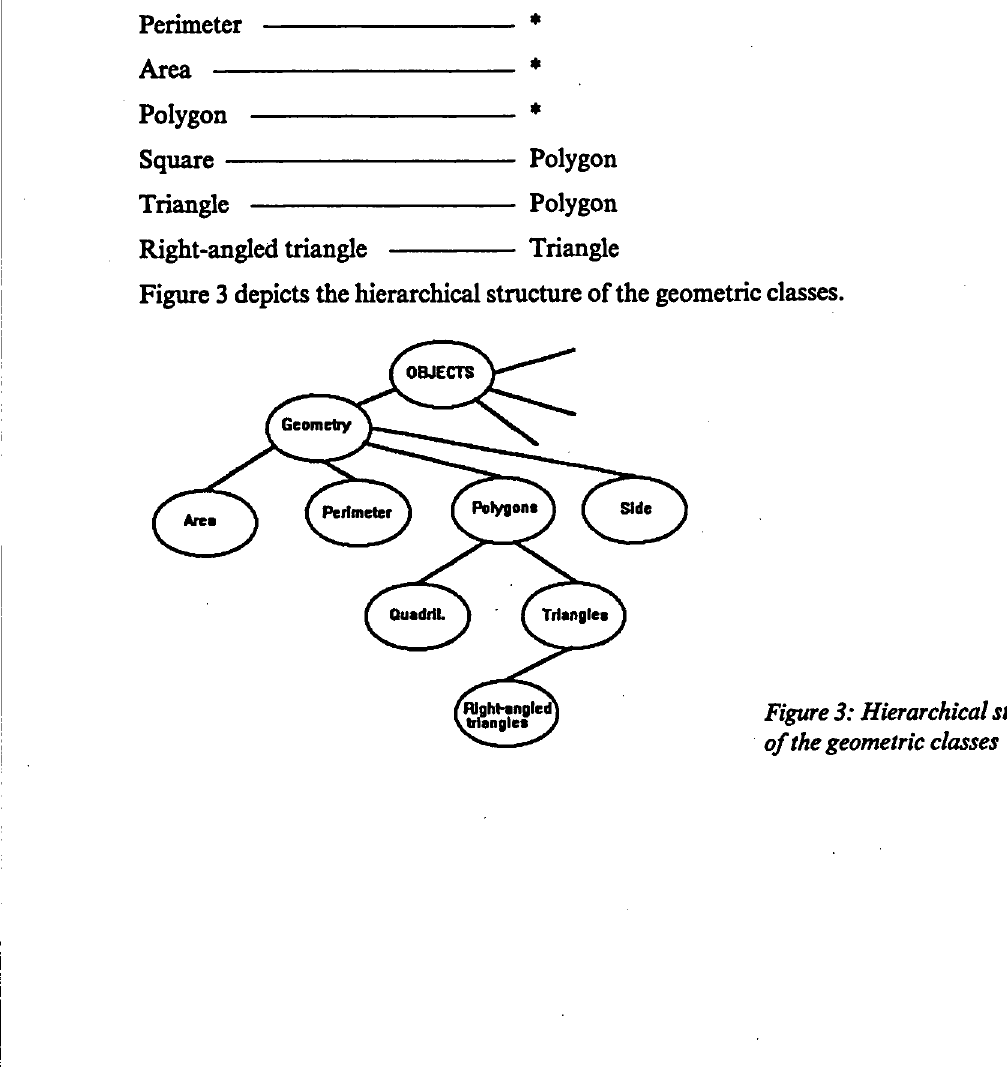
Figure 3: Hierarchical